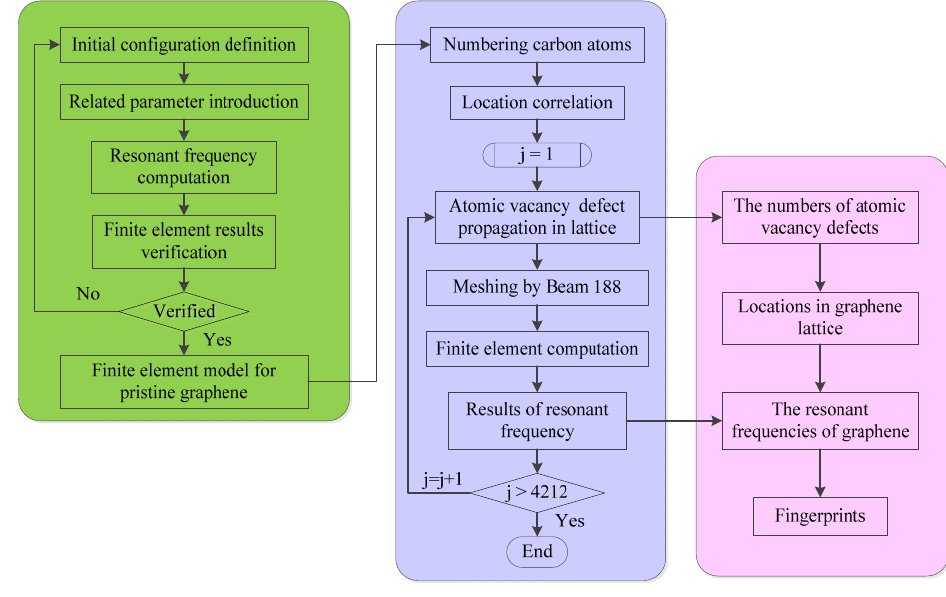
Figure 2. The flowchart of fingerprint compiler.